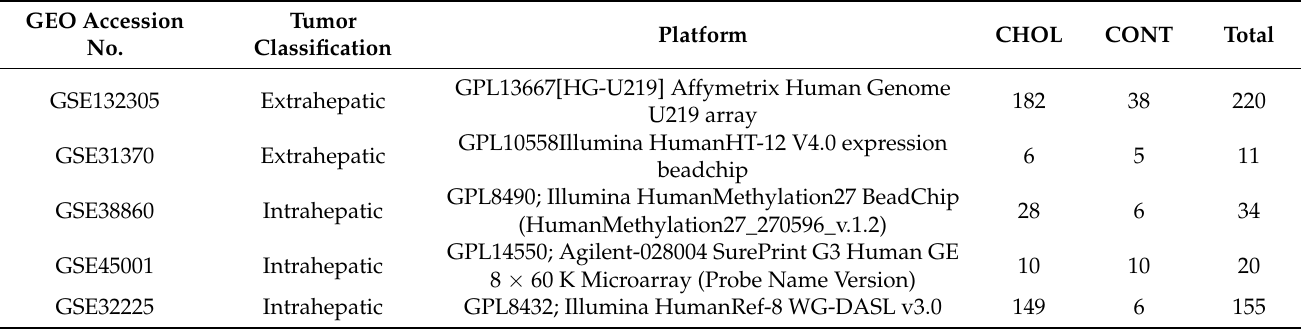
Table 1. Characteristic of the cholangiocarcinoma (CHOL) datasets used for differentially expressed gene identification. GEO Accession